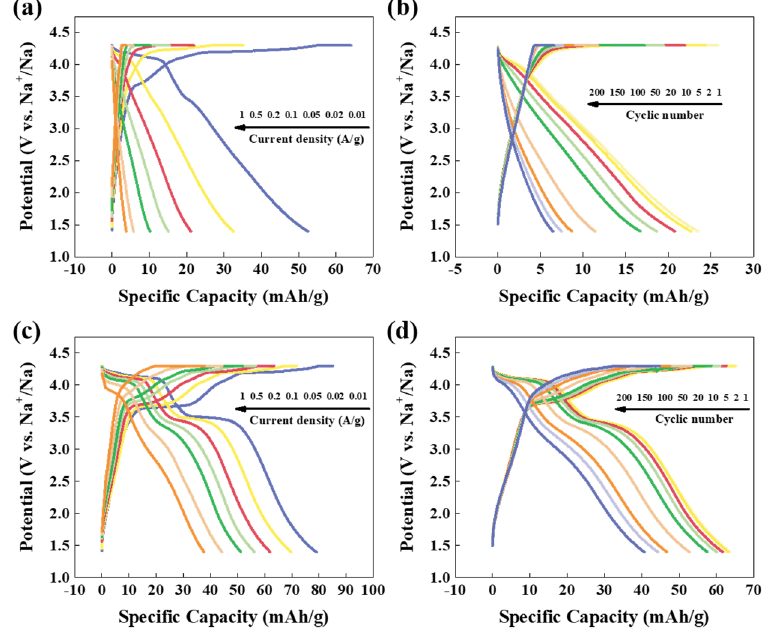
Figure 9. ( a ) Galvanostatic charge/discharge curves of the NMCP electrode at different current rates from 0.01 to 1 A/g. ( b ) Representative charge/discharge curves of NMCP at 0.1 A/g. ( c ) Galvanostatic charge/discharge curves of the NMCP/rGO electrode at different current rates from 0.01 to 1 A/g. ( d ) Representative charge/discharge curves of NMCP/rGO at 0.1 A/g.